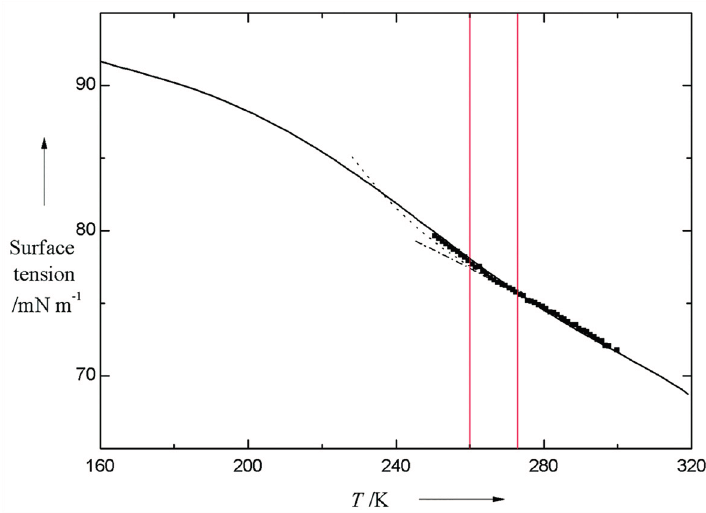
Figure 2. Comparison of surface tension as a function of temperature. Dot dashed line: calculated from early IAPWS equation [32], dashed line: calculated from advanced IAPWS equation by incorporating a new term [33], solid line: calculated by employing a two-state model [27], solid square: experimental results by Hacker [26]. The two red straight lines are schematic symbols to guide the eyes to the inflection point existing between the lines. It should be noted that there is a big discrepancy in surface tension between two-state model and developed IAPWS equation below the temperature of inflection point, even though a remarkable agreement existing at the higher